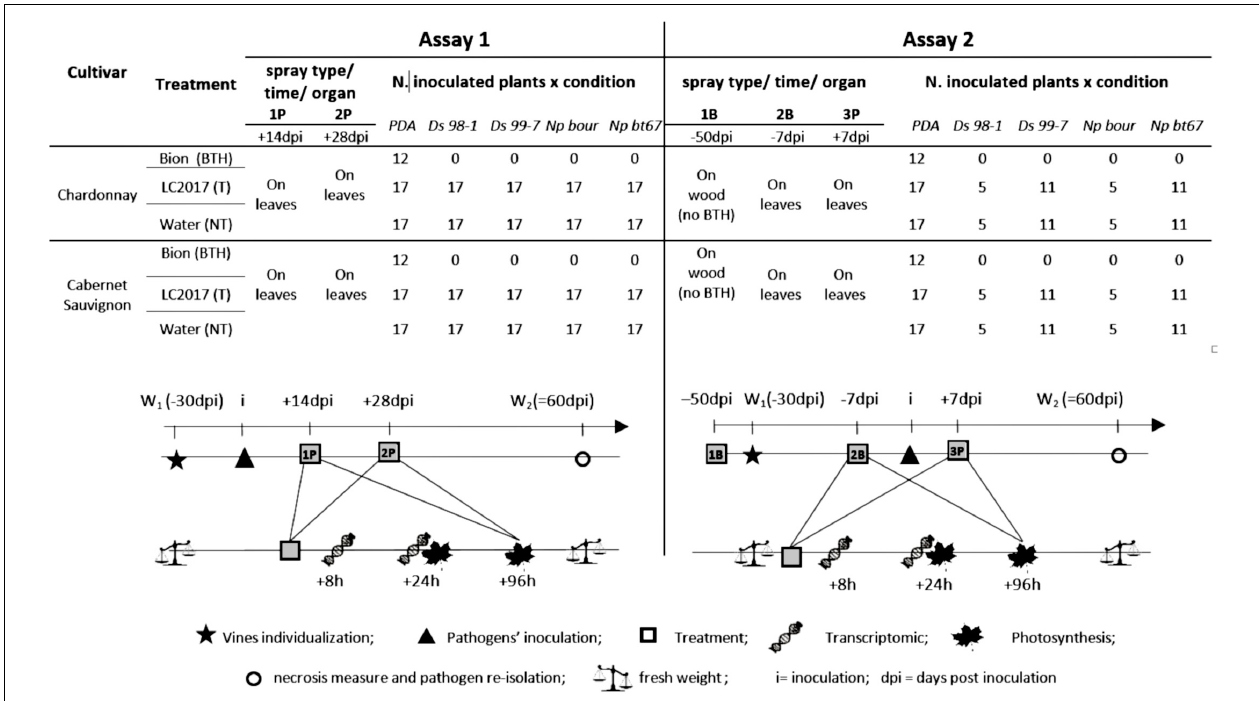
FIGURE 1 | Scheme of the greenhouse bioassays followed to evaluate the effects of LC2017 on vine physiology and Botryosphaeria dieback development. For each assay are reported the different treatments (BTH = treated with commercial product elicitor of plant defense system; T = treated with LC2017; NT = treated with water), the number and the type (P = Post inoculation, B = Before inoculation) and their timing according to artificial inoculations (dpi = days post inoculation), the target organ of treatment and the number of vines followed for each condition. Below, the timing followed for pathogens inoculation (i), treatments, photosynthesis measures, transcriptomic study, plant fresh weight measures, necroses measure, and pathogen re-isolation.